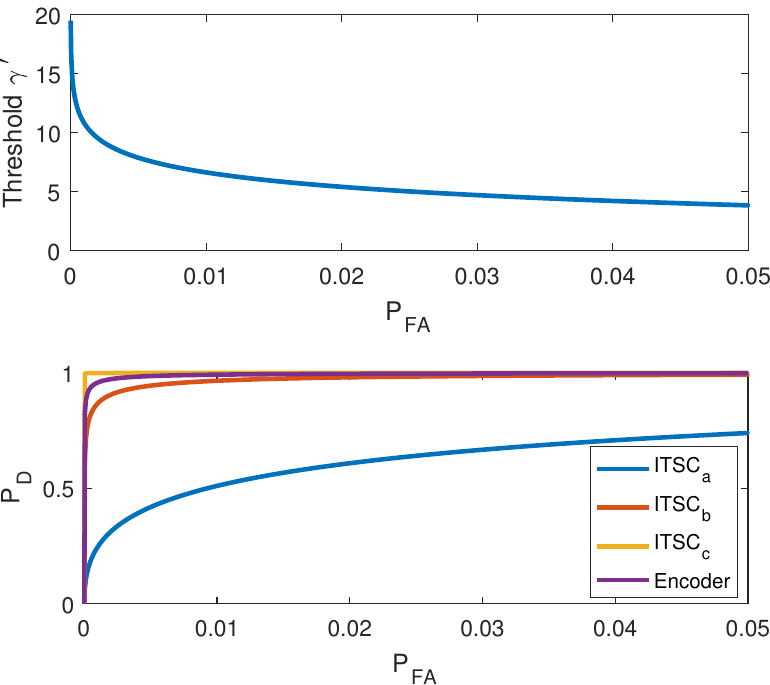
Figure 13. Threshold and ROC for low values of P FA